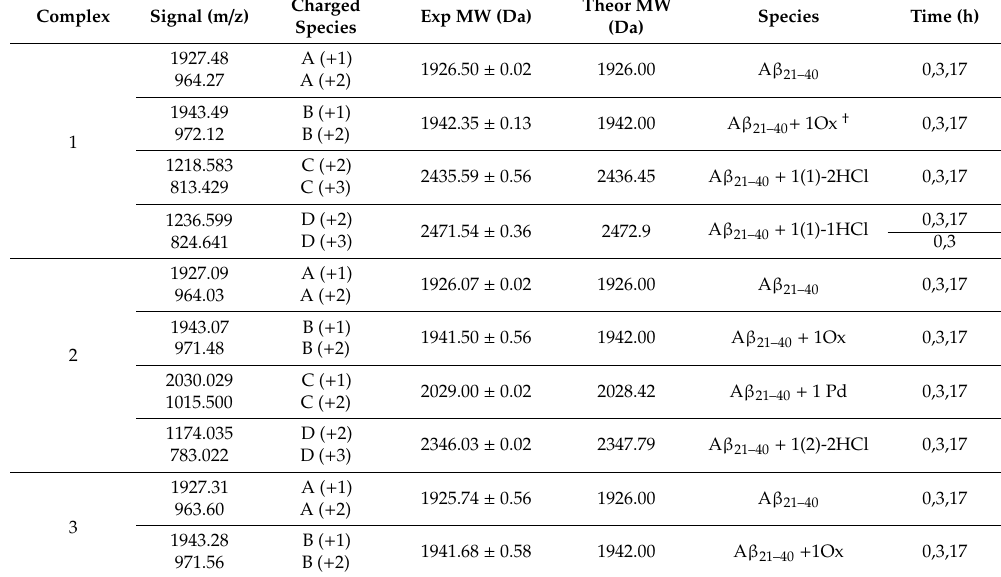
Table 3. Results of the ESI-MS analysis of the adducts formed by the reaction of A β 21–40 with 1 , 2 and 3 . The experimental m / z values, the ion charge status, the experimental (Exp) and theoretical (Theor) monoisotopic mass values, the corresponding ion species and times of incubation are